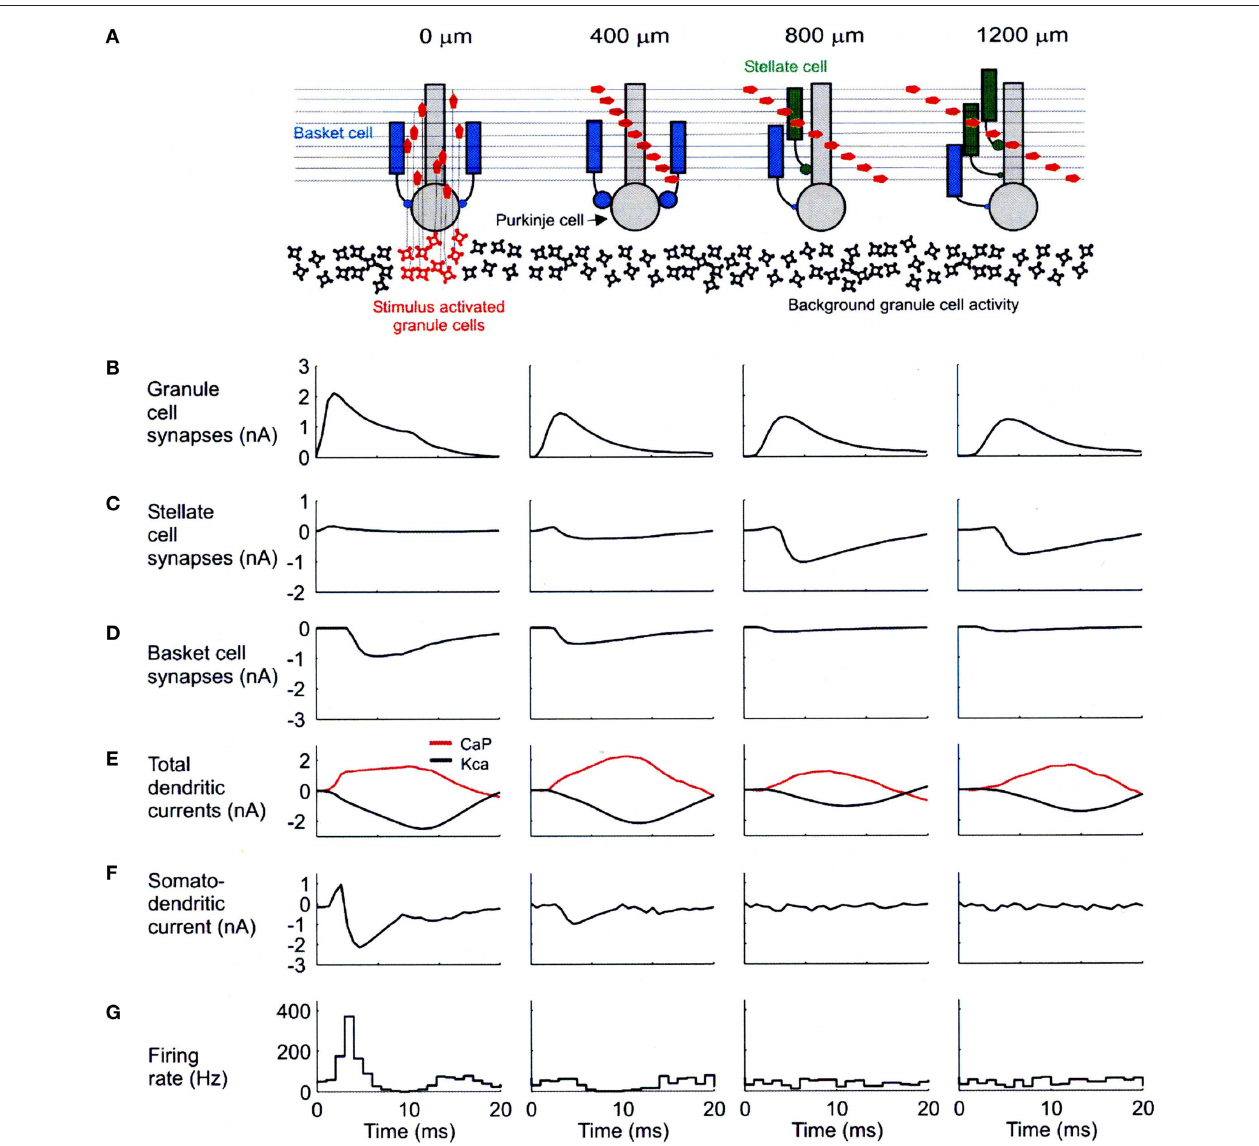
400 m the background activated synapses shunt the excitatory depolarization from granule cells. (D) Total basket cell synaptic currents. (e) Total dendritic calcium P currents (CaP, red) and calcium activated potassium currents (Kca, black) with respect to basal levels of activity after synaptic stimulation. (F) Net somato-dendritic current regulating the firing rate of the PC. (g) PSTH showing the resulting somatic response. All plots correspond to PCs at distances indicated in the schematic diagram at the top of the figure. Positive current is inwards in (B–e) and toward the soma in (F) . Averages calculated from 64 simulations in (B–e) and 256 in (F) . Reproduced with permission from Santamaria et al., 2007.